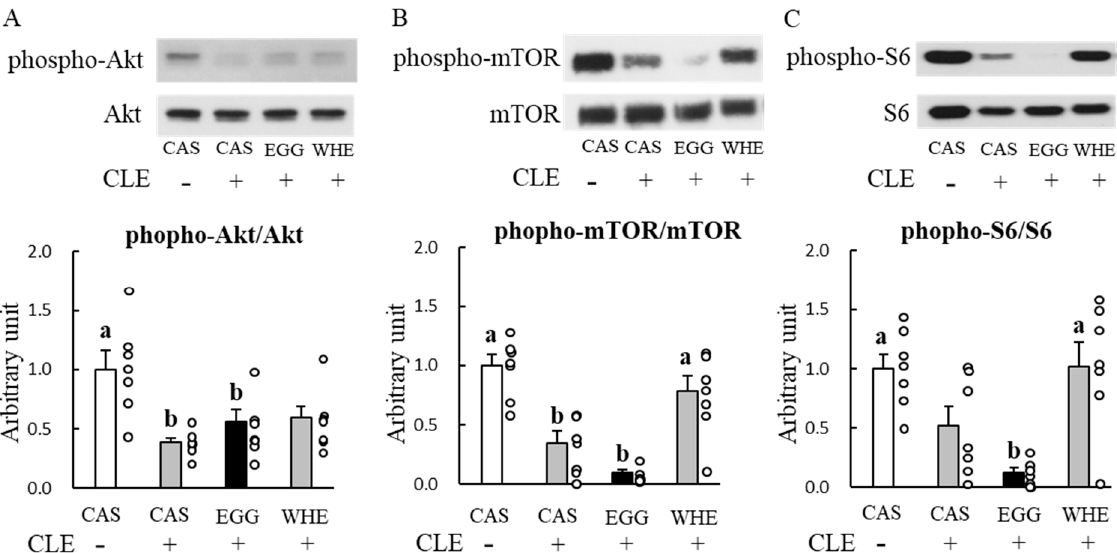
Figure 13. Chronic effect of each protein feeding on muscle signal transduction (Day 7). Rats were assigned to either a casein, egg white, or whey protein diet group, and were maintained under ad libitum feeding for 6 days with or without clenbuterol administration. On day 7, rats were fated for 6 h, and then plantaris muscles were dissected out for western blot analysis of Akt ( A ), mTOR ( B ), or S6 ( C ). The dots beside bars indicate individual value. Values are means ± SE ( n = 7). CAS: casein protein, EGG: egg white protein, WHE: whey protein. CLE: clenbuterol. Different superscript represents statistical differences among groups.